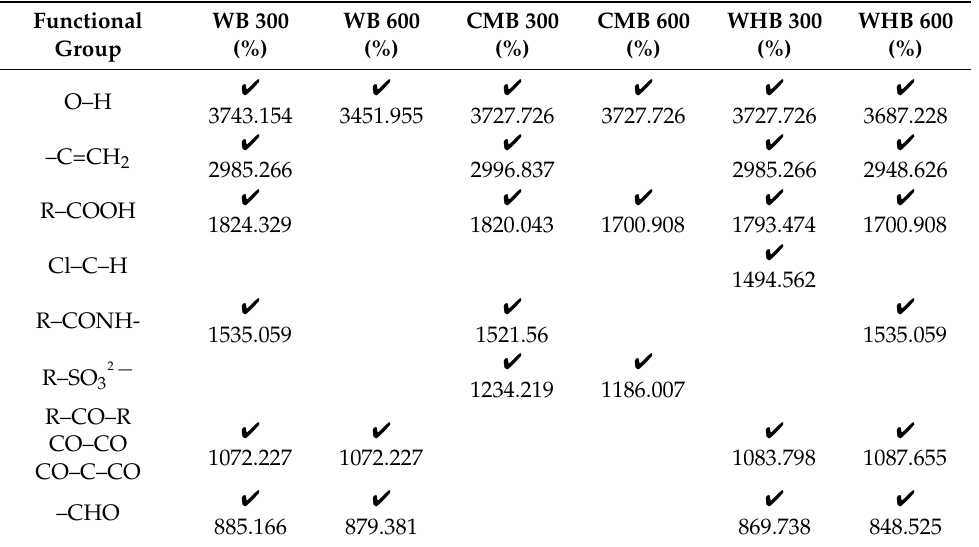
Table 3. Characteristics wavenumber and the corresponding transmittance of biochar.